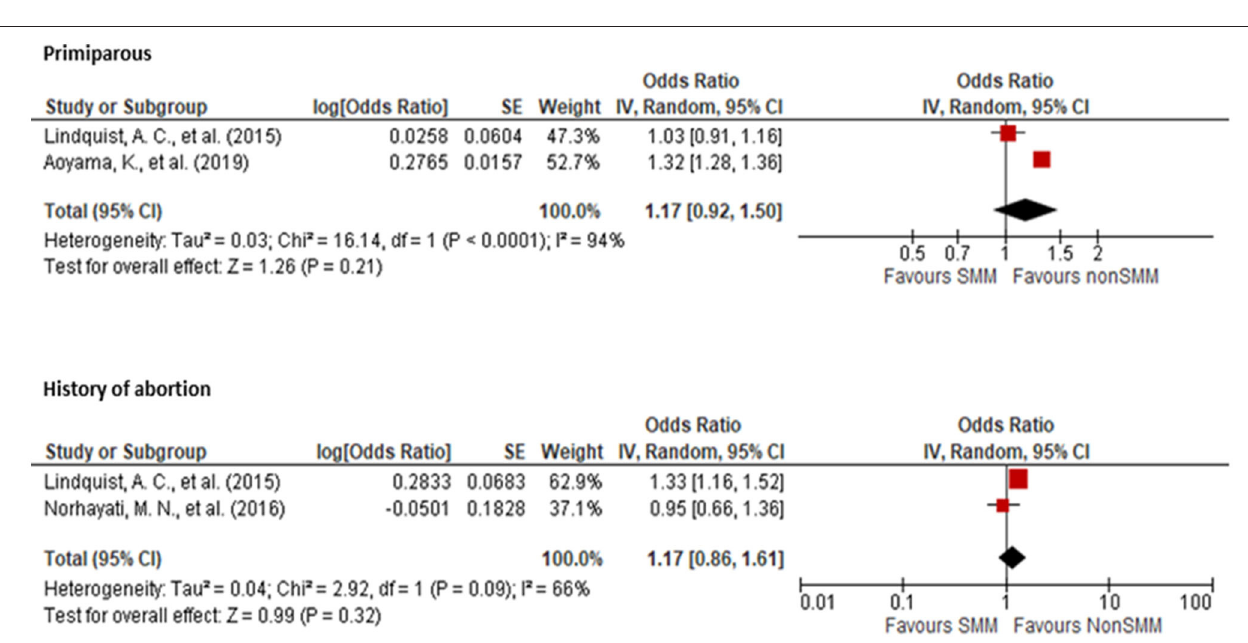
SMM. Two studies (12, 19) reported an association between a history of cesarean section and SMM with an OR of 1.63 (95% CI: 1.43, 1.87) when compared to women with only a history